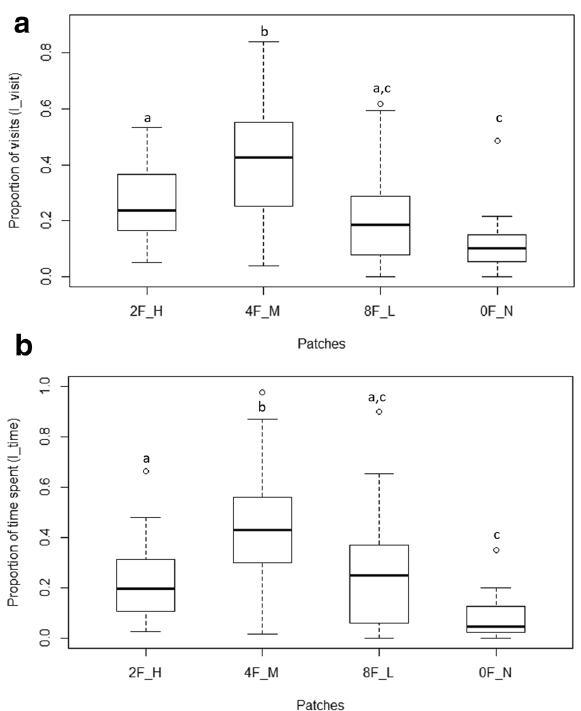
Figure 5. ( a ) Boxplots showing the proportion of visits by the male to the various chambers (E2 set). Males visited the medium (M) chamber (four females and medium plant density) significantly more than the high (H) (two females with high plant density), low (L) (eight females with low plant density) or Null (N) (one female with no plants) chambers. H patch also had greater proportion of visits compared to N patch. Similar alphabets placed above the plots indicate no statistical difference whereas dissimilar alphabets indicate significant statistical difference (p < 0.05). The lower and upper ends of the box plots represent the 1st and 3rd quartiles, the horizontal line within each boxplot is the median, and the upper and lower whiskers are the ×1.5 the interquartile range. Outlines are shown as open circles. ( b ) Boxplots showing the proportion of time spent (I_time) by the male in each of the chamber (E2 set). The test males spent statistically greater proportion of time in M patch compared to the other three patches. H patch also had greater proportion of time spent compared to N patch. Similar alphabets placed above the plots indicate no statistical difference whereas dissimilar alphabets indicate significant statistical difference (p < 0.05). The lower and upper ends of the box plots represent the 1st and 3rd quartiles, the horizontal line within each boxplot is the median, and the upper and lower whiskers are the ×1.5 the interquartile range. Outlines are shown as open